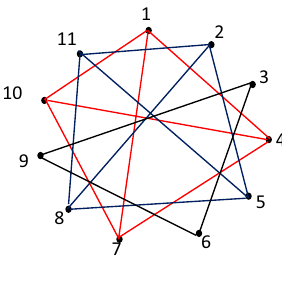
Fig. 4 Case n = 11 ; m =